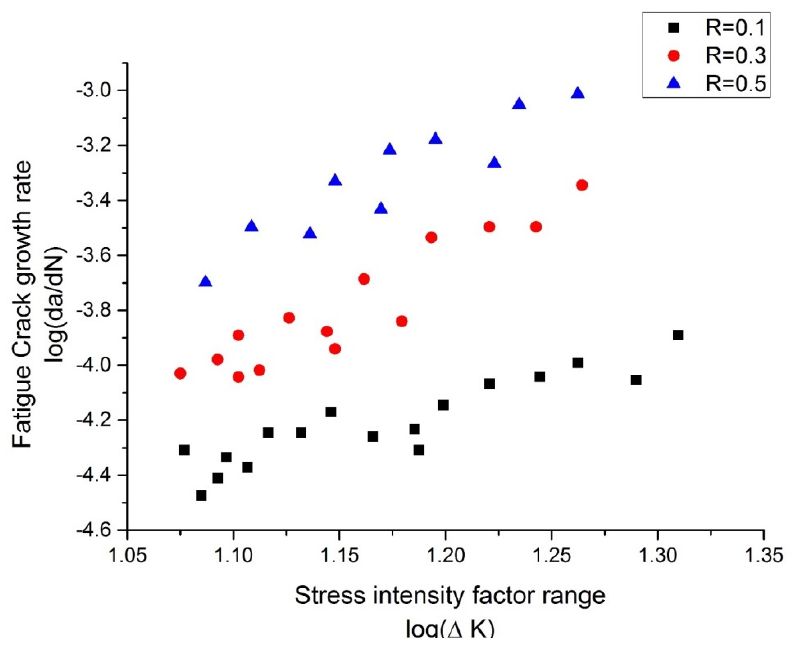
Figure 5. Effect of different stress ratios on crack growth rate [60].